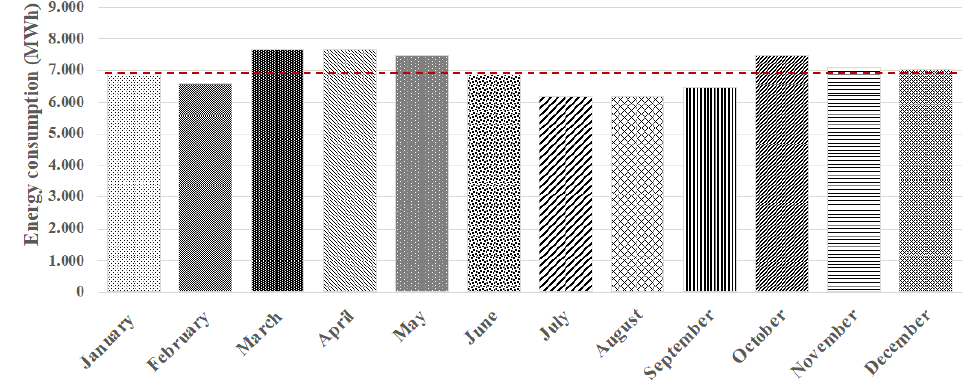
Figure 6. Energy consumption for each month of 2018, red line demonstrates the